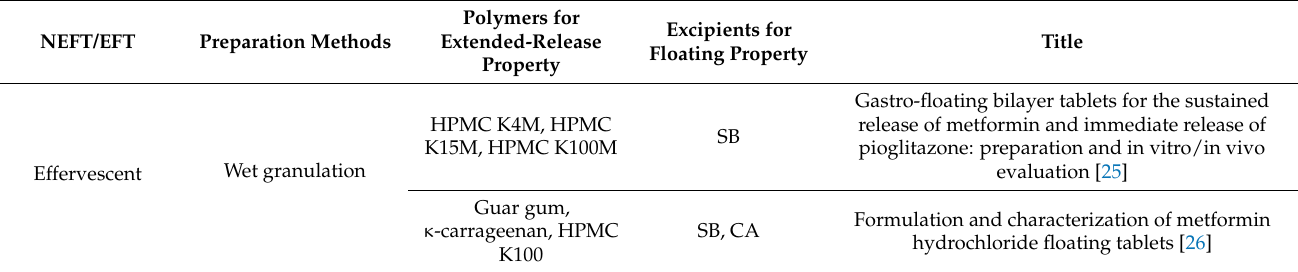
Table 1. Summary of reported floating drug delivery systems for Metformin